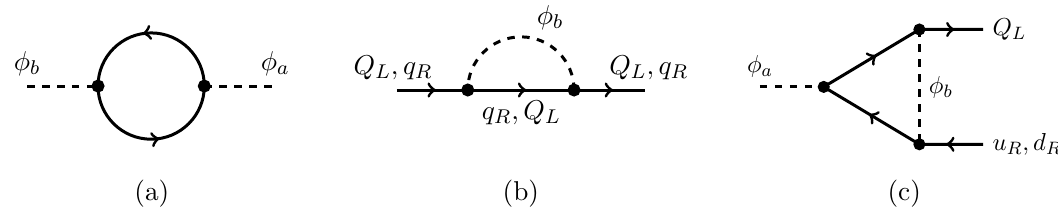
Figure 1. One-loop topologies generating the (cid:13)avour structures in eqs. (5.1), (5.2) and (5.3): scalar self-energies (a), Q L and q R self energies (b), and vertex corrections (c). in eq. (2.2) satisfy the RGEs [21,